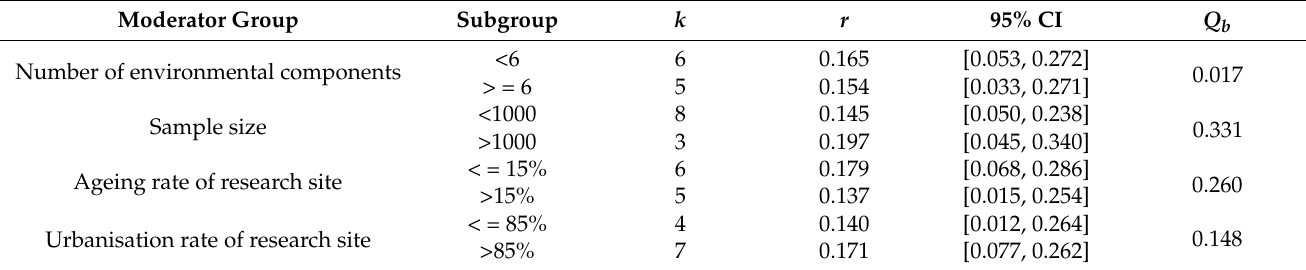
Table 3. Moderator analysis of the association between AFEs and mental